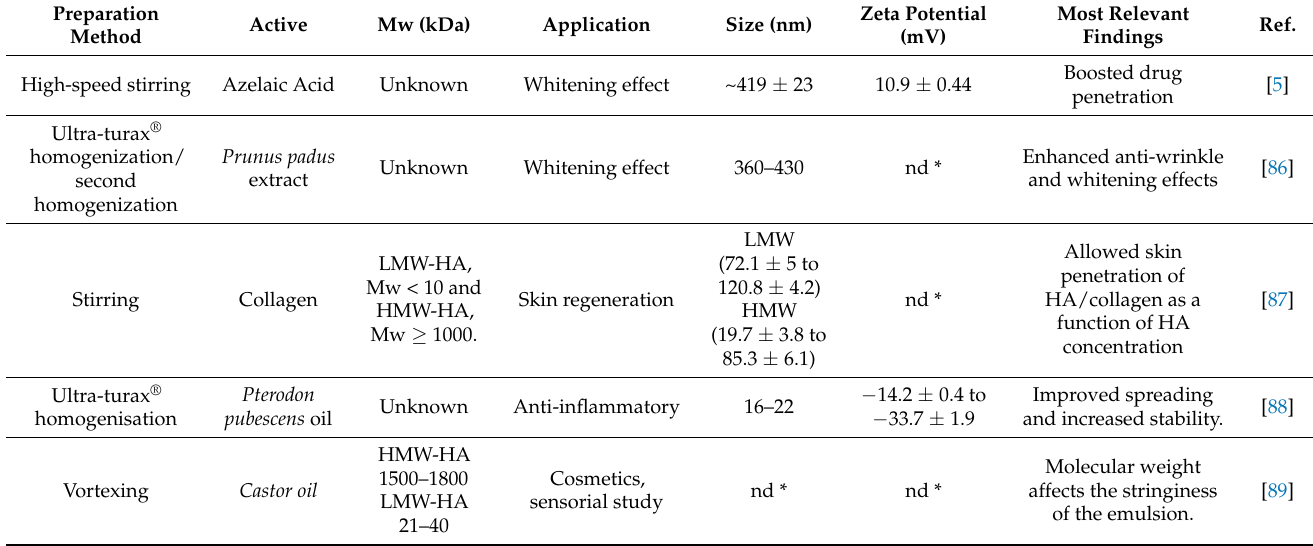
Table 2. Evaluation parameters of HA-containing micro and nanoemulsions (* nd—zeta potential or size were undefined in the